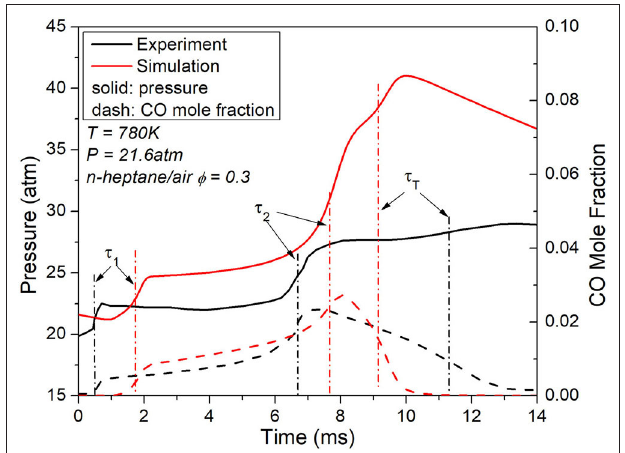
FIGURE 2 | Measured and simulated temperature and CO evolution for the RCM ignition of n-heptane/air at φ = 0.3, P = 21.6 atm and T = 780K.